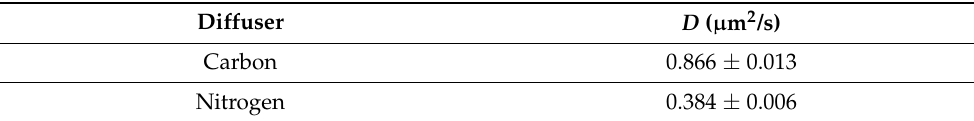
Table 2. Diffusion coefficients D of carbon and nitrogen without taking into account the interaction of the flow of diffusing